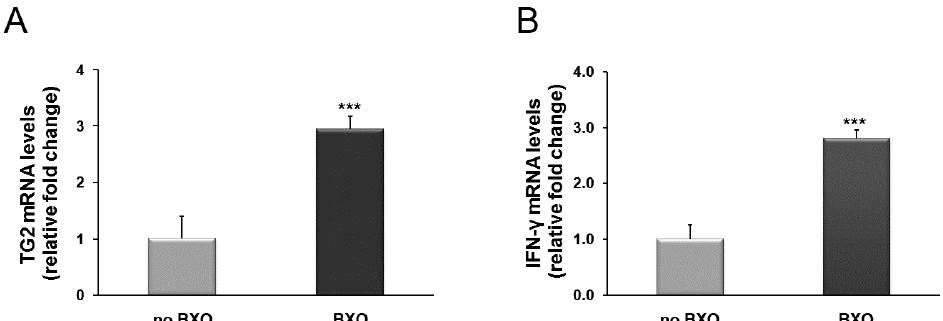
Figure 1. Changes in mRNA levels of TG2 ( A ) and IFN- γ ( B ) in foreskin tissues from patients with BXO expressed as relative fold changes compared with patients without BXO (no BXO). The results are the means of data obtained from 15 patients with BXO and 15 patients without BXO. Error bars represent standard error of the mean (SEM). *** p < 0.0001 shows significant differences in comparison with patients without BXO.